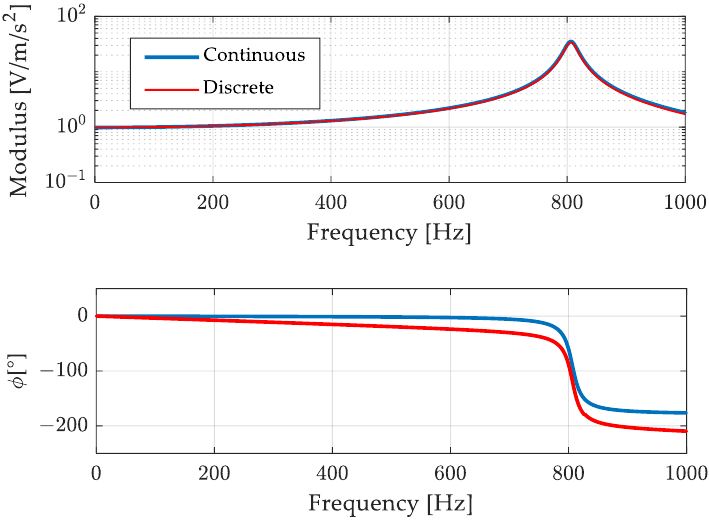
Figure 11. Comparison of the continuous frequency response function with its discrete version.